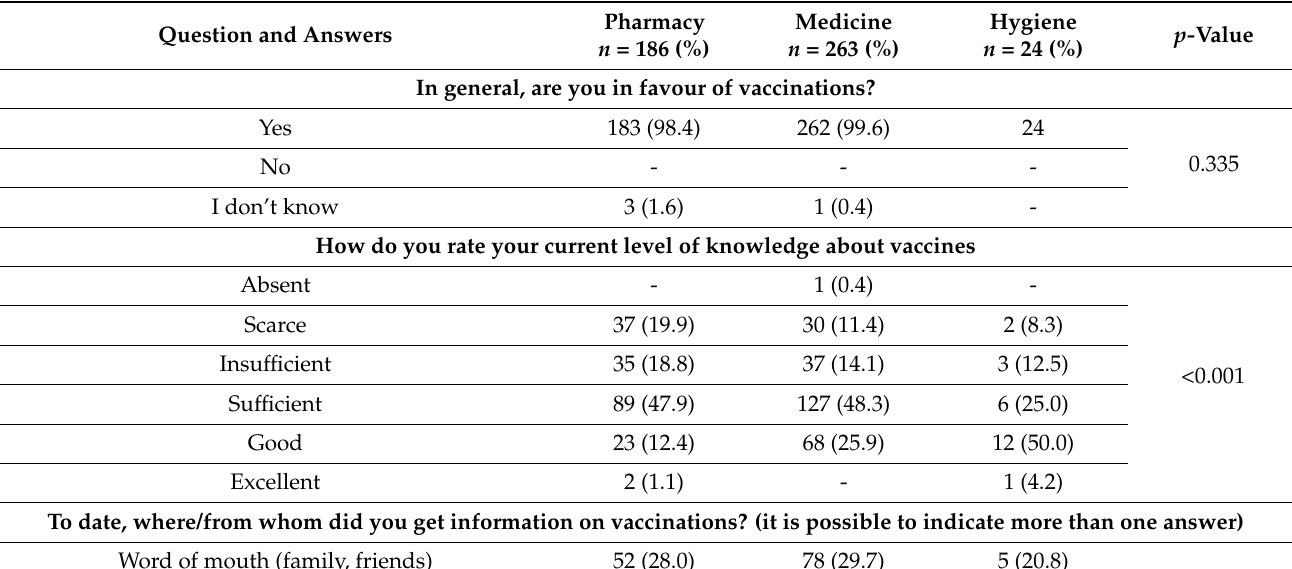
Table 2. General questions about the knowledge on vaccines and sources of information on this